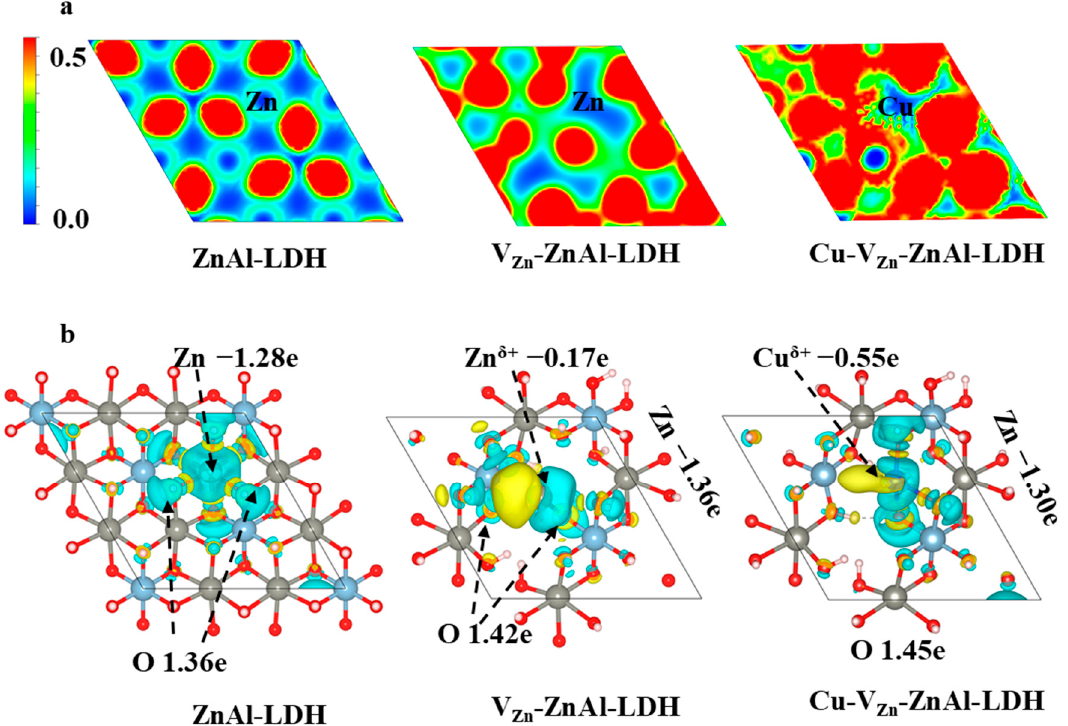
Figure 4. ( a ) Electron localization function (ELF) and ( b ) electron density difference (EDD) and Bader charges of the three ZnAl-LDHs.